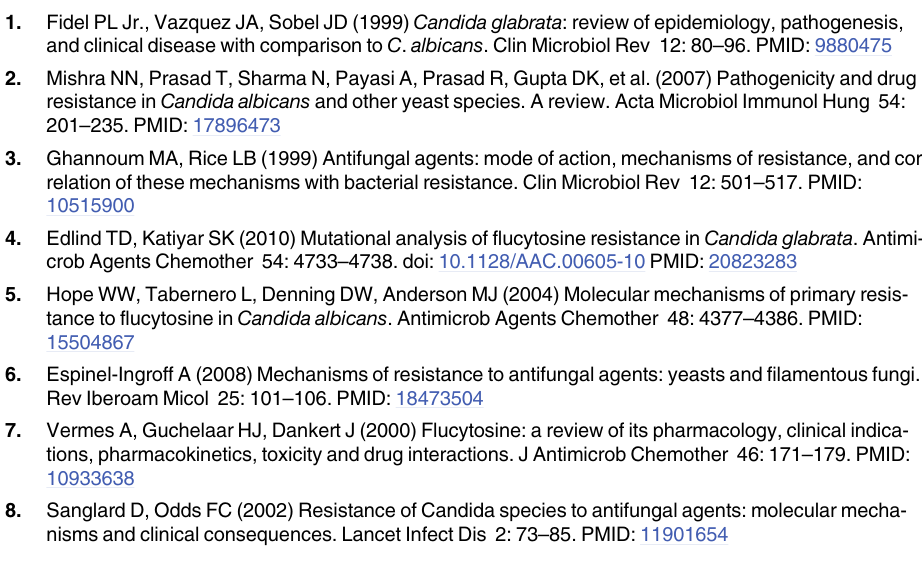
S1 Fig. Schematic representation of the homologous recombination procedure used for the deletion of CgFPS1 and CgFPS2 in the KUE100 C . glabrata strain, and of the selection of the primers used to confirm the deletion of these genes in their chromosomal locations. The results obtained for the confirmation of these constructs are shown below, using the paren- tal strain as a control. S1 Table. Complete list of genes identified in this study as conferring resistance to 5-flucy- tosine, clustered into functional groups according to their description in the Saccharomy- ces Genome